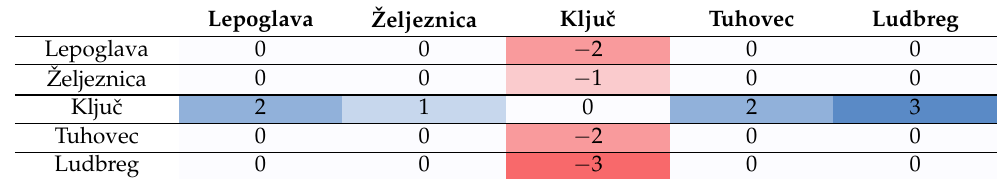
Table 7. Cross-correlation lag times matrix for the measurement stations. The red to blue color bar indicates values between − 3 and